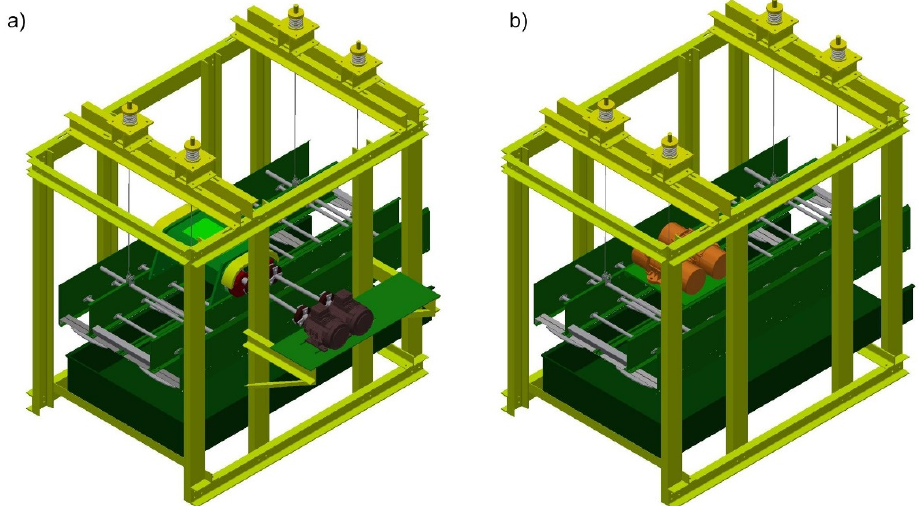
Figure 6. View of WP laboratory screen models: ( a ) before modernization; ( b ) after modernization.